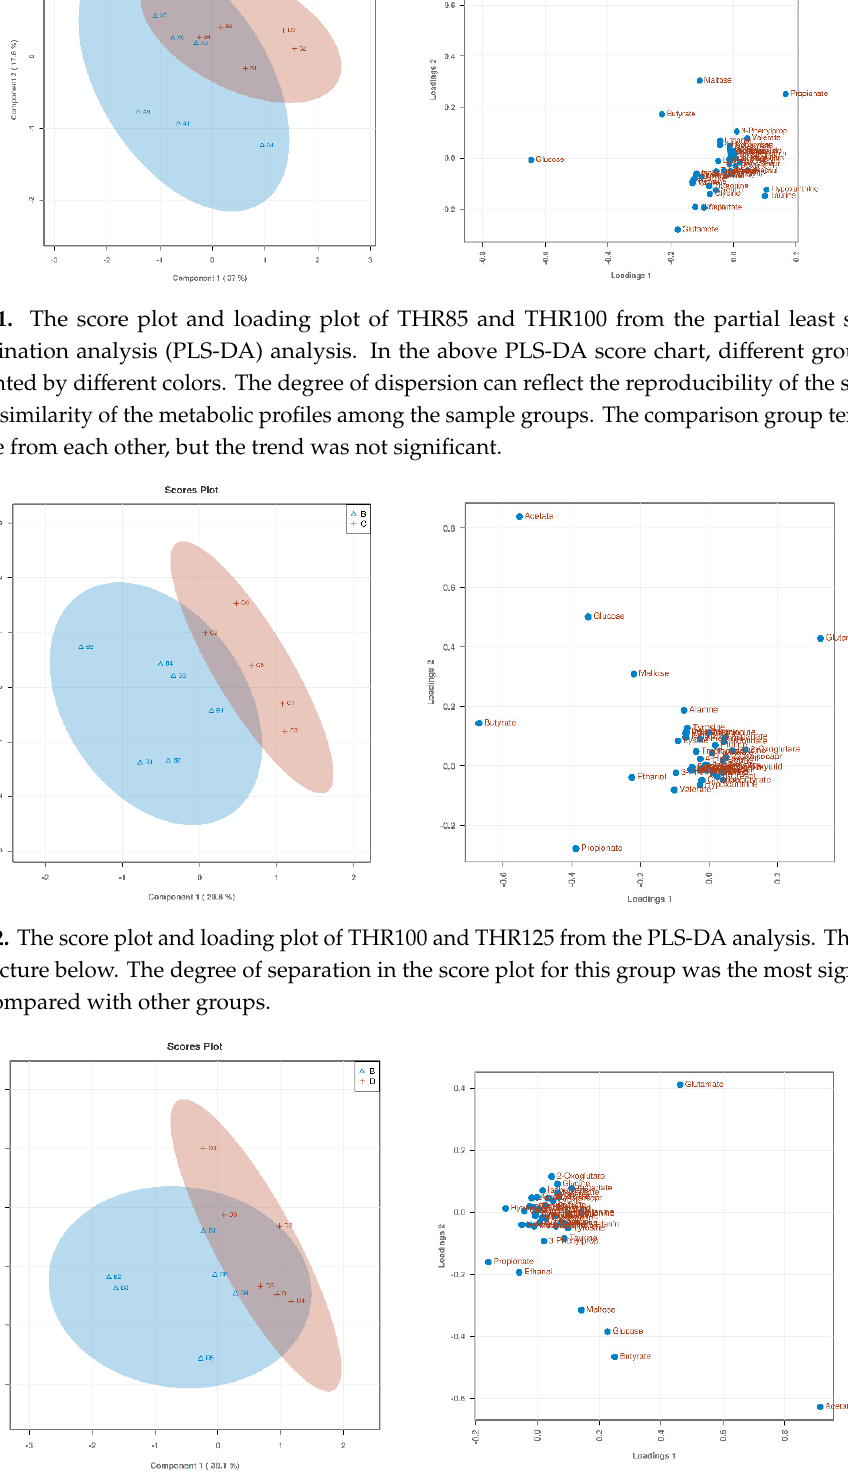
Figure 3. The score plot and loading plot of THR100 and THR150 from the PLS-DA analysis. In the above PLS-DA score chart, the comparison group tended to separate from each other, but the trend was not